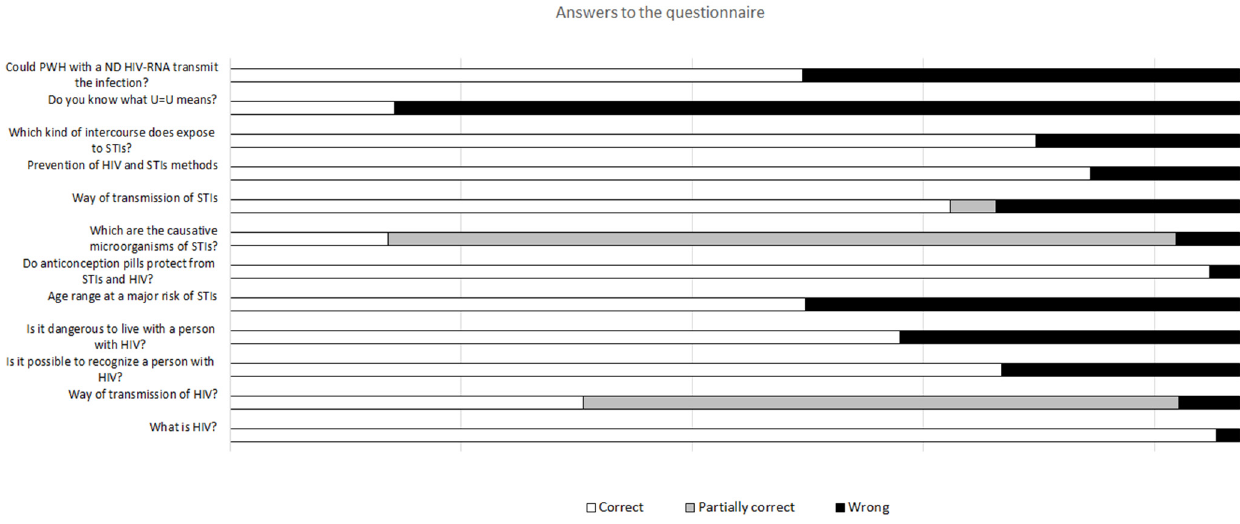
Figure 1. Answer to the 12 questions present in the